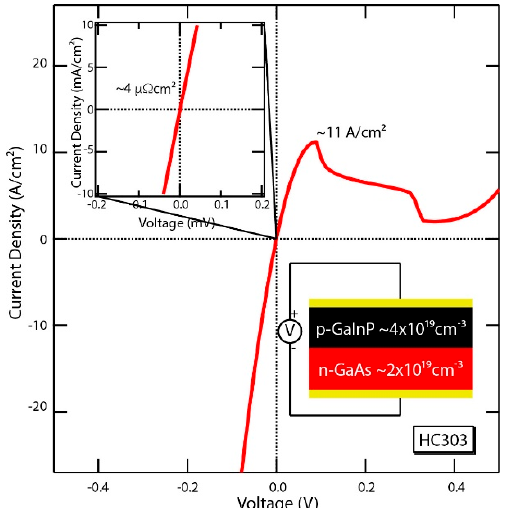
Figure 4. Current-density-voltage characteristics for a tunnel junction grown using D-HVPE. Inset shows an amplified look around 0 V showing the low resistance of the tunnel junction.